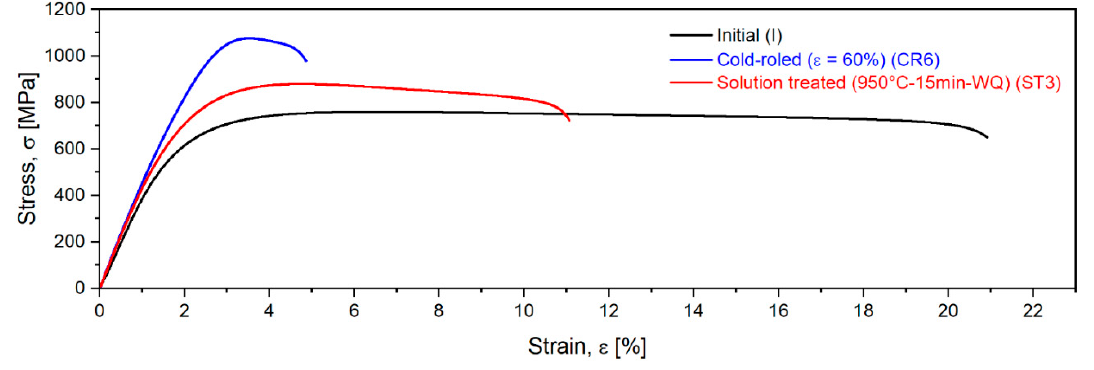
Figure 10. The stress–strain curves of the samples corresponding to the 2nd step of the TMT program (sample selected from the 1st step). Table 2. Mechanical properties of the studied alloy at the end of the 1st direction of experiments from the TMP Program: Ultimate Tensile Strength ( σ UTS) ; Yield Strength ( σ 0.2) ; Elongation to Fracture ( ε f ); Elastic Modulus (E); SD—Standard Deviation.